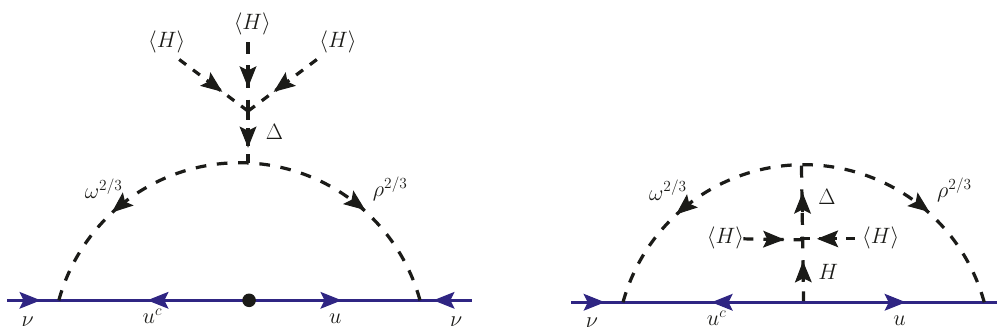
Figure 1 . Feynman diagram generating neutrino masses through the exchange of LQs in the model. The one-loop diagram shown is the leading contribution, while the two-loop diagram can be important. The dot ( • ) on the SM fermion line in the one-loop diagram indicates mass insertion arising from the SM Higgs doublet VEV. There is a second set of diagrams obtained by reversing the arrows on the internal